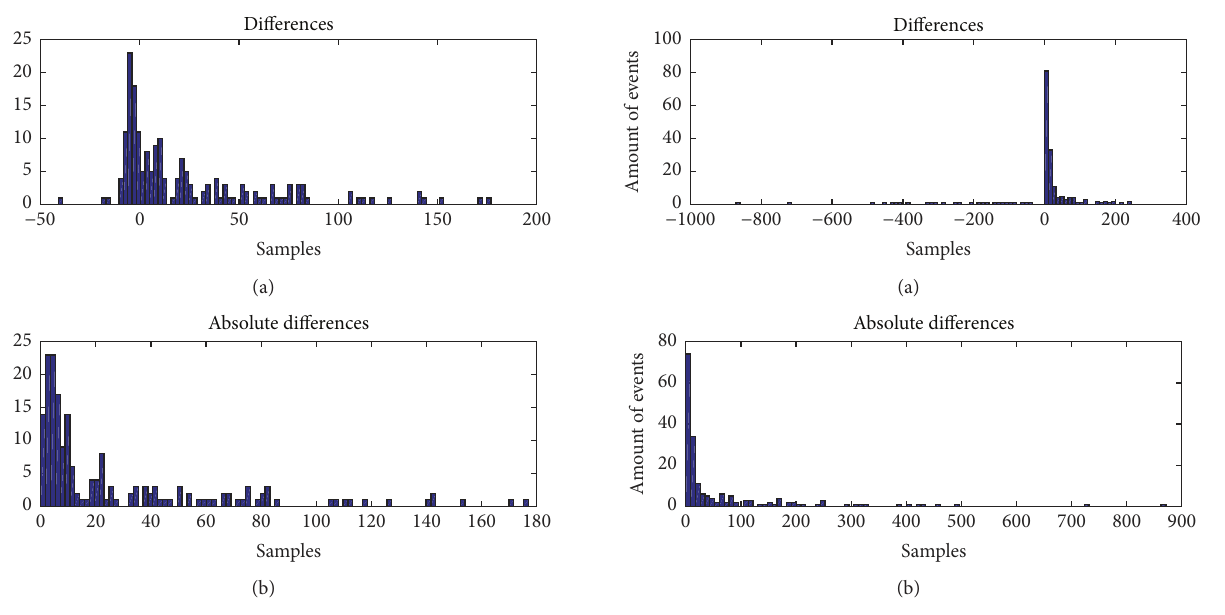
Figure6:HistogramofabsolutedifferencesbetweenSTA/LTApicks and those given by experts (a) and histogram of absolute differences (b).